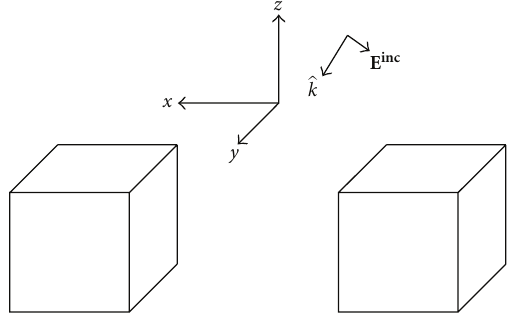
Figure 10: Two coating PEC cubes.